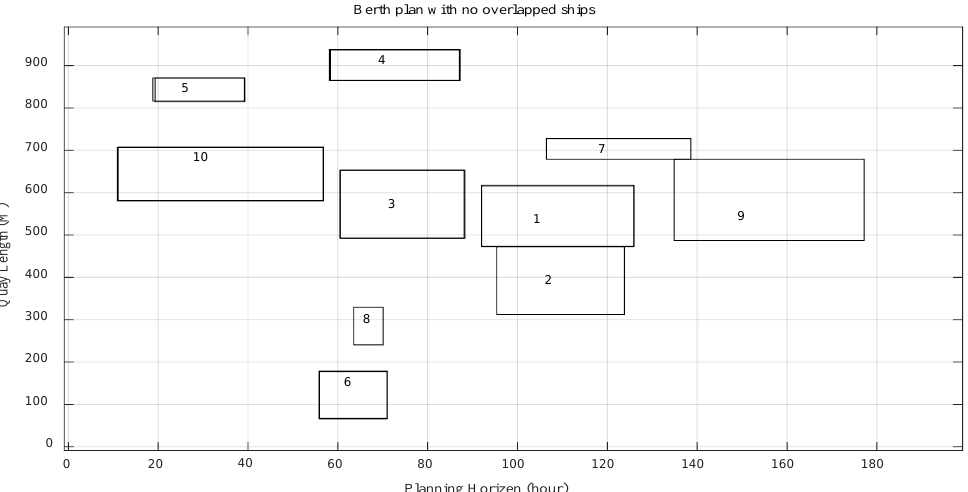
Figure 12. The berth plan with no overlapped ships ( N = 10 ships).